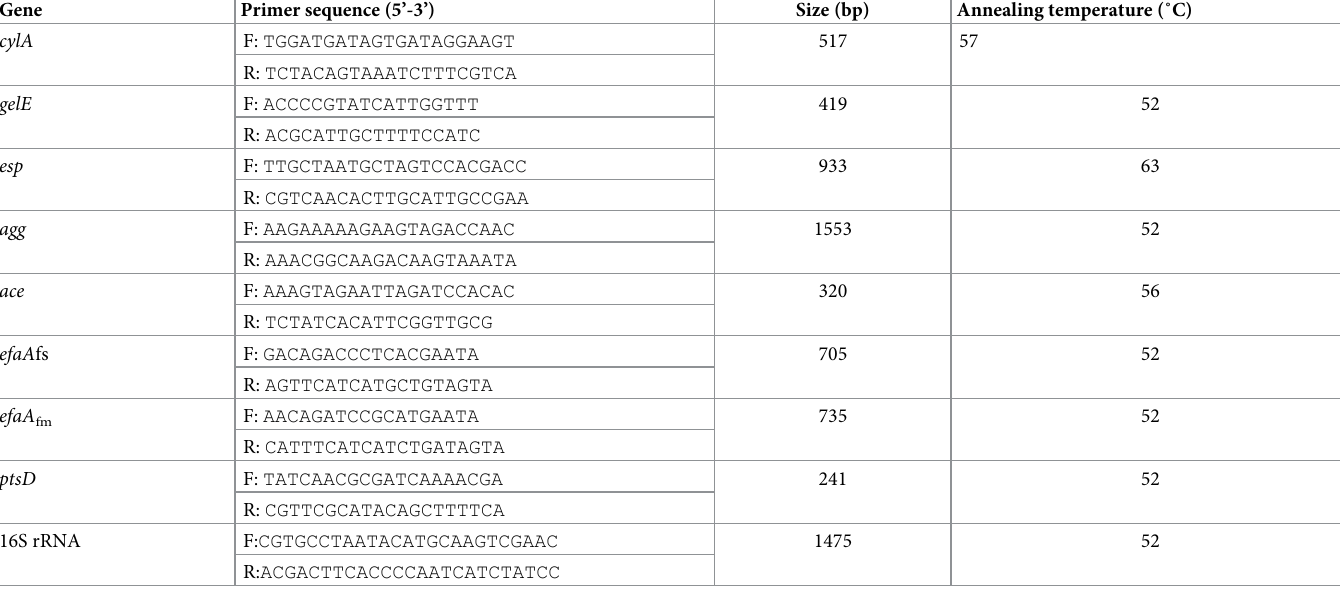
Table 1. PCR primers and conditions used in amplifications for the detection of virulence in E . thailandicus TC1. Gene Primer sequence